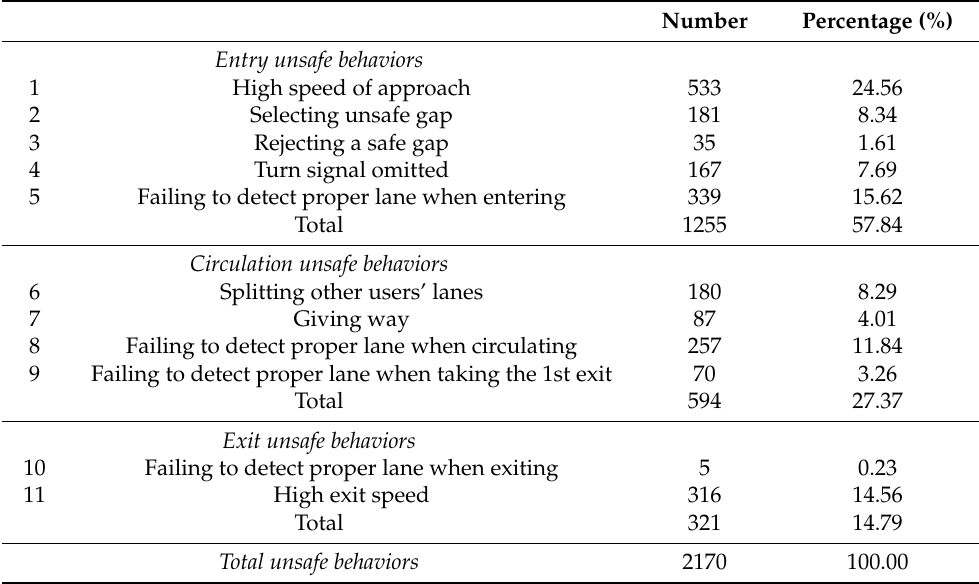
Table 3. Number of unsafe behaviors observed.